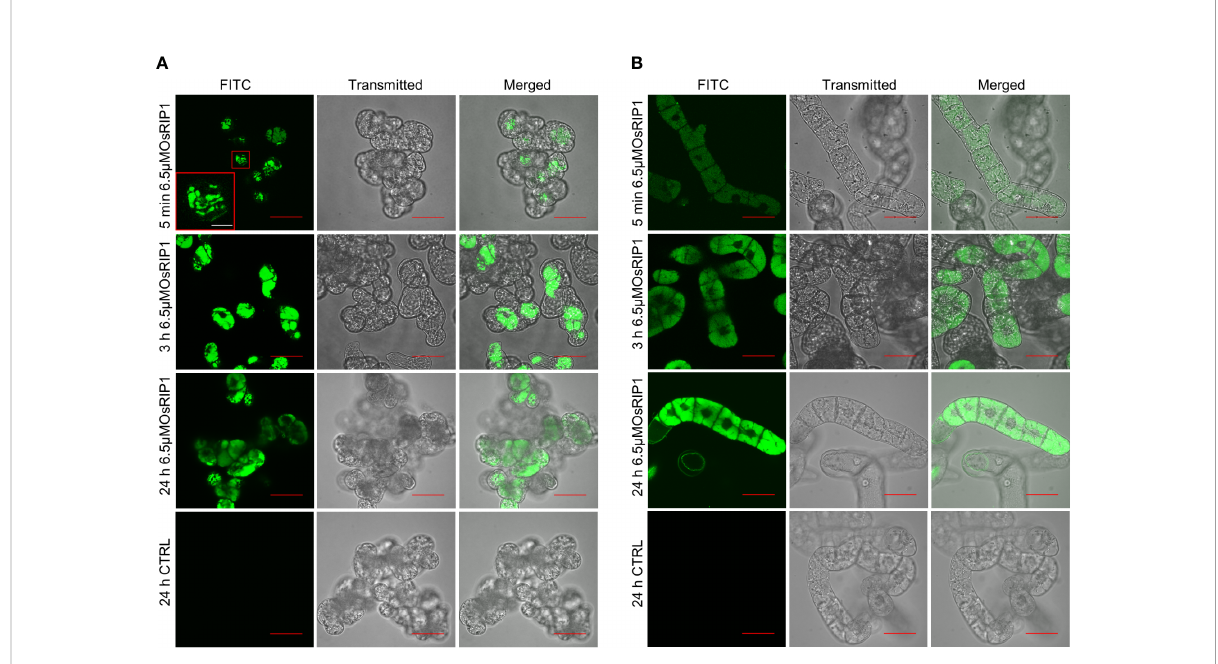
FIGURE 2 Confocal imaging of OsRIP1 accumulation in PSB-D cells (A) and BY-2 cells (B) after 5 min, 3 h and 24 h treatment with 6.5 m M OsRIP1 conjugated with FITC using a fi lter set Ex488/Em532.5. All scale bars in red indicate 50 m m, while the white bar refers to 10 m